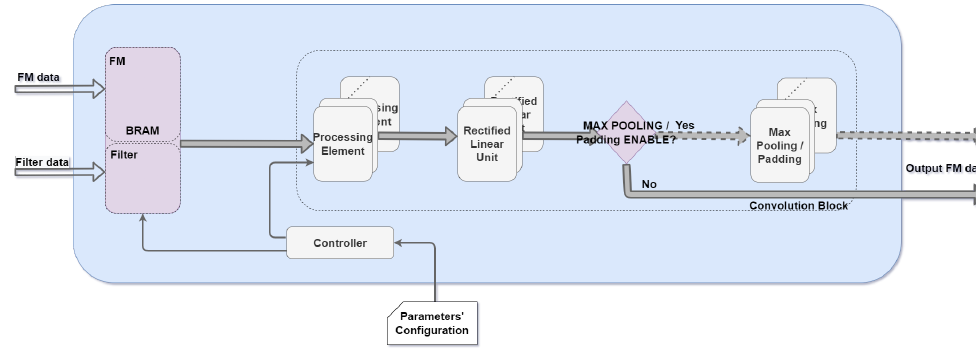
Figure 1. Convolution block architecture